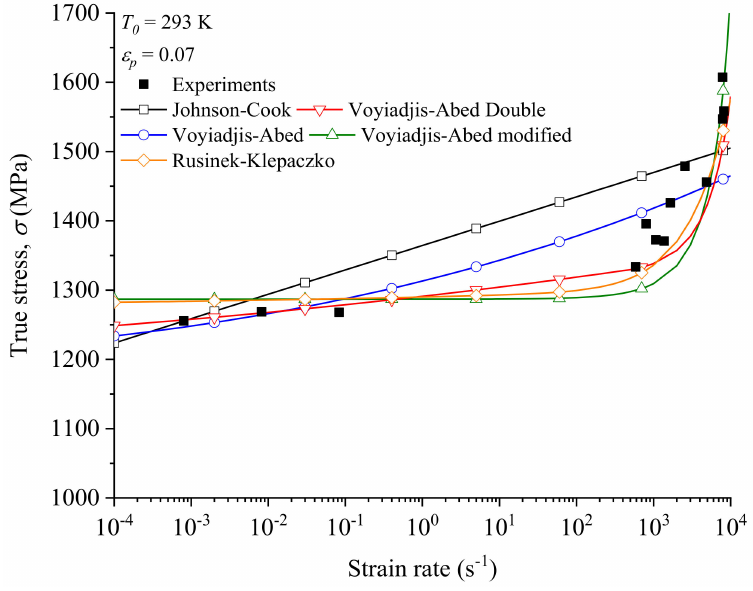
Figure 17. Equivalent stress vs. strain rate for a strain level of ε p = 0.07 at room